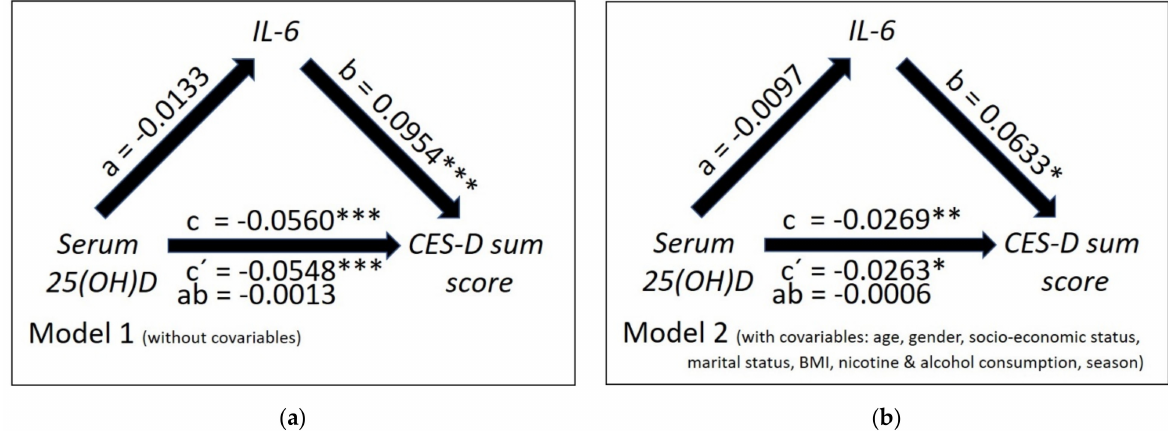
Figure 3. Mediation model without ( a ) and with covariates ( b ) showing both the total and direct effect of serum 25(OH)D concentrations on the intensity of depressive symptomatology as measured by CES-D sum scores (path coefficients c and c (cid:48) ) and the indirect effect of serum 25(OH)D concentrations on CES-D scores mediated through interleukin 6 (IL-6) concentrations (path coefficient ab) in the study sample. The figure depicts the unstandardized path coefficients (a,b,c,c (cid:48) and ab; with * p < 0.050; ** p < 0.010; *** p <